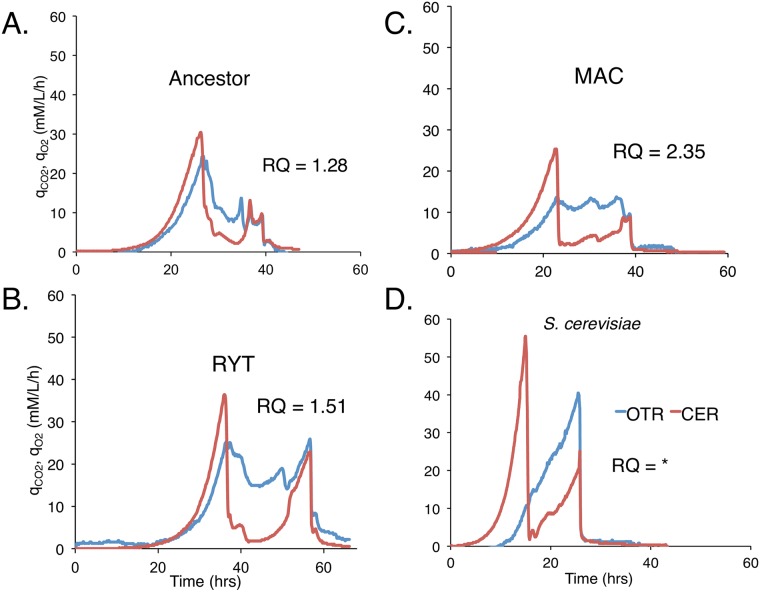
CO2 Evolution Rate (CER) and O2 Transfer Rate (OTR) profiles for aerobic batch fermentations of the (A) ancestor, (B) RYT, (C) MAC and (D) S. cerevisiae.* RQ value for S. cerevisiae strains differ from strain to strain but our laboratory strain (CEN.PK 113-7D) has an RQ value of 4.48 ± 0.72. Respiratory activity was calculated from data compiled from bioreactors fitted with exhaust gas analyzers and mass transfer equation was used to calculate OTR and CER (mM/l/h). Oxygen uptake before the diauxic shift decreased over time and in general MAC seems to have evolved to be less dependent on O2. The first drop in CER at 25.5 hrs (ancestor), 35.3 hrs (RYT), 22 hrs (MAC) and 14.7 hrs (S. cerevisiae) coincides with glucose exhaustion. The second drop in CER indicates depletion of alternative carbon sources. The plateau of OTR in MAC profile represents the maximum transfer rate of the system, implying reduction in oxygen demand during the growth phase.